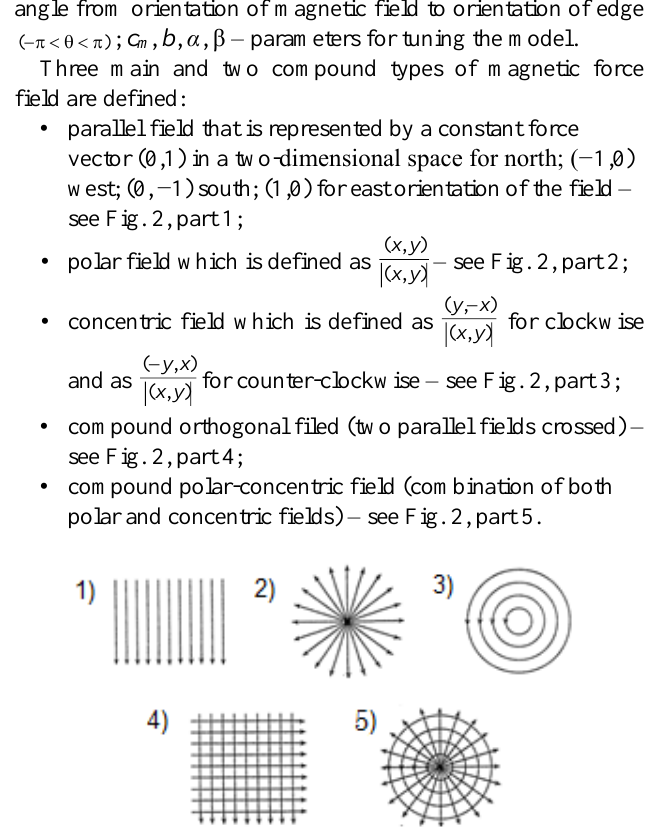
Fig. 2. Types of force fields in a magnetic-spring